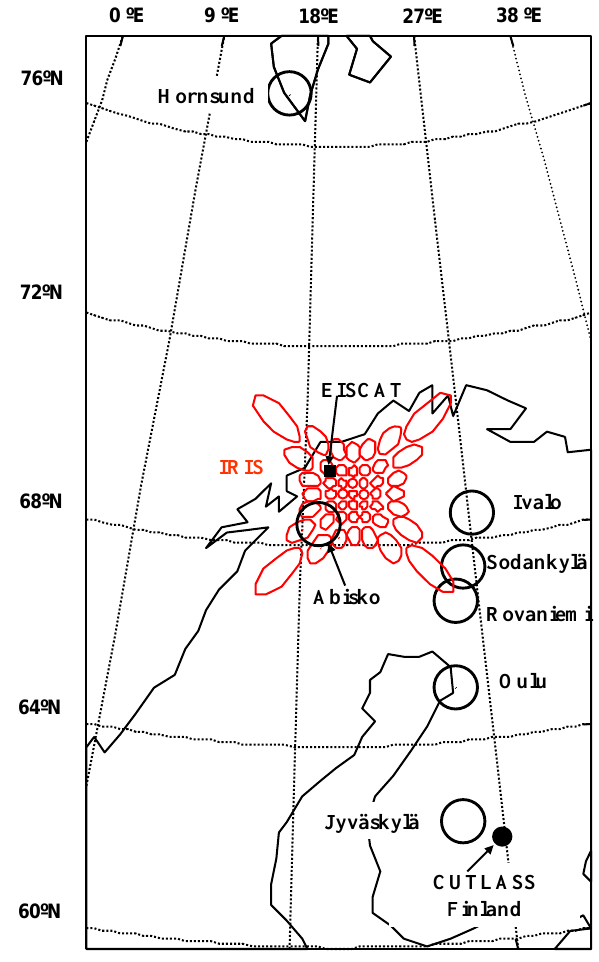
Fig. 1. A map of northern Scandinavia illustrating the positions of some of the instruments used in this study. This includes IRIS, EISCAT, CUTLASS and the SGO riometer chain. The pulsa- tion magnetometer is co-located with IRIS at Kilpisj¨arvi (69.05 ◦ N, 20.79 ◦